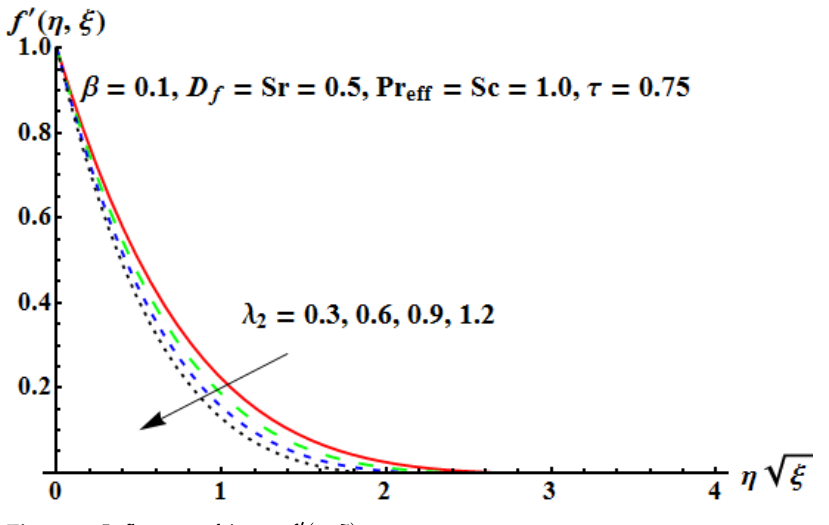
Figure 9. Influence of λ 2 on f (cid:48) ( η , ξ ) .